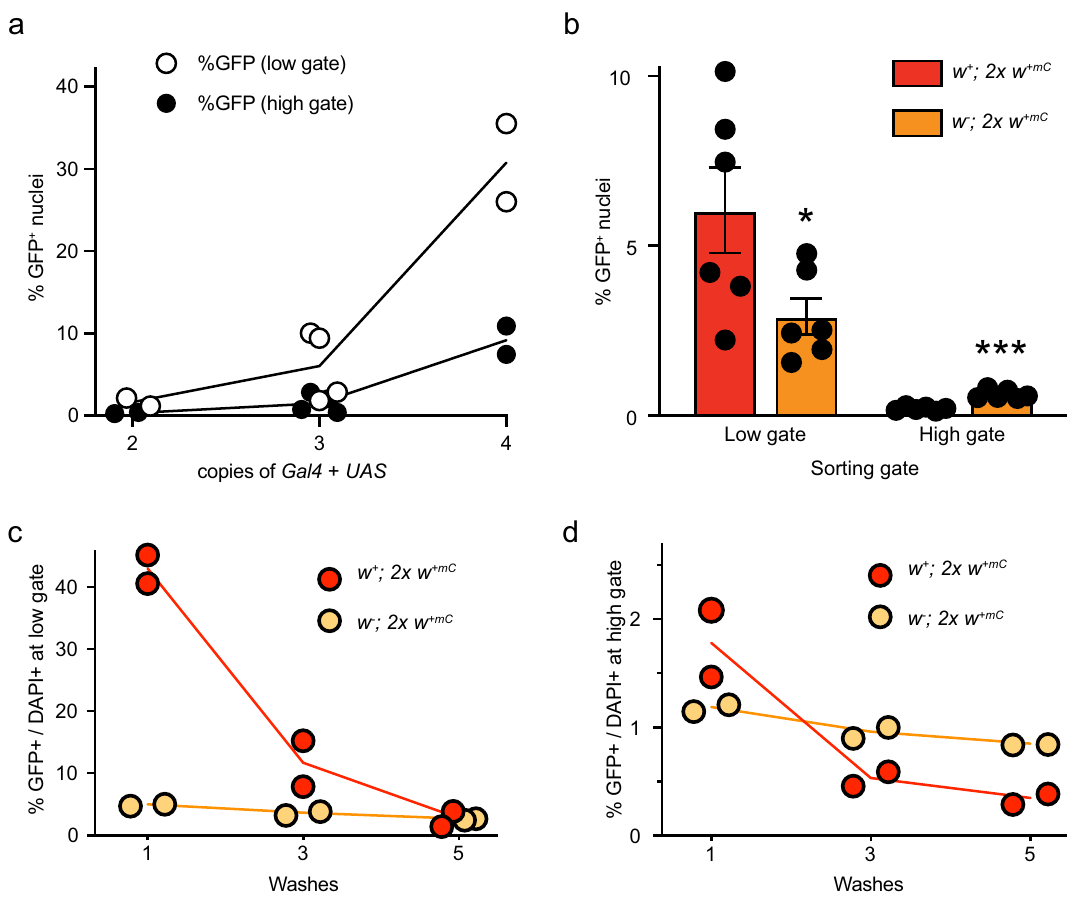
Figure 4. Physical parameters affecting ATAC-seq library preparation from Drosophila nuclei. ( a ) GFP+ nuclei from flies expressing multiple copies of Gal4 + UAS ( ics-Gal4 UAS-GFP-nls ) were isolated and analyzed by flow cytometry using low- and high-stringency gating. ( b ) Nuclei from cholinergic neurons ( Cha-Gal4 UAS-GFP- nls ) in red-eyed ( w + background) and orange-eyed flies ( w – background). Error bars represent the mean ± SD of six biological replicates and were analyzed by Student’s t-tests. ( c , d ) Nuclei from the same flies used in ( b ) were washed multiple times before analysis using low- ( c ) and high- ( d ) stringency gating. The data were analyzed using linear regression. All regression lines have slopes ≠ 0, p <